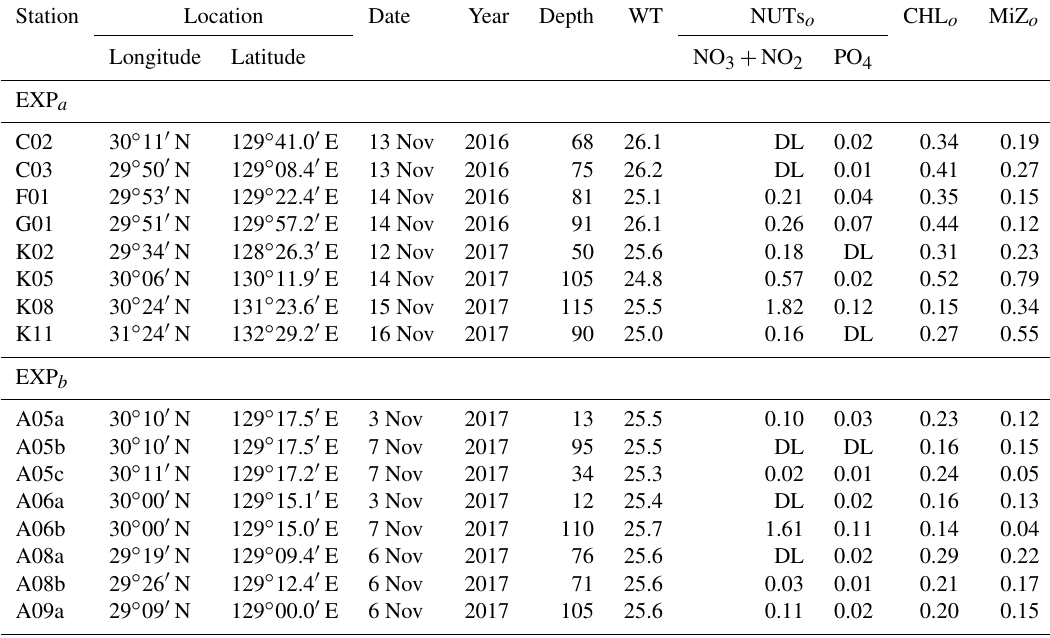
Table 1. Location and environmental conditions at the stations in the ECS-Kuroshio where gradient enrichment (EXP a ) and dilution ex- periments (EXP b ) were conducted. Depth: sampling depth (m) of water samples for each experiment. WT: mean water temperature during the experiments ( ◦ C). NUTs o : nutrient concentrations (µmolL − 1 ) at the beginning of each experiment. CHL o : chlorophyll a concentration (µgCHLL − 1 ) at the beginning of the experiments. MiZ o : microheterotroph standing stock at the beginning of each experiment (µgCL − 1 ). DL: below the detection